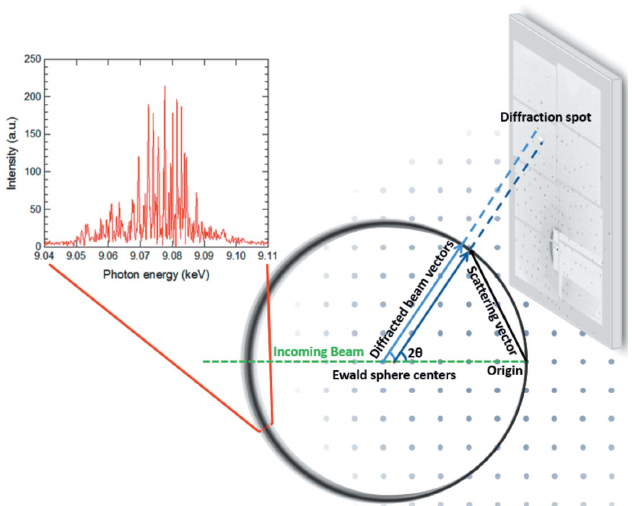
Figure 8 Schematic of the scattering geometry. Spectral width (black circle) and reciprocal lattice point size (gray spots), exaggerated for clarity. The inset shows an example of a measured spectral distribution from BL3 at SACLAwhen using a 9.07 keV beam (Inubushi et al. , 2017). Note that the photon energy used in our experiments was 17.00